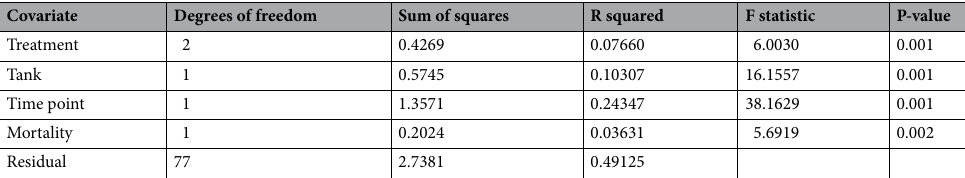
Table 1. PERMANOVA results assessing the marginal effects of treatment, tank, time, and mortality on weighted unifrac distances of gut swabs from experimental juveniles.